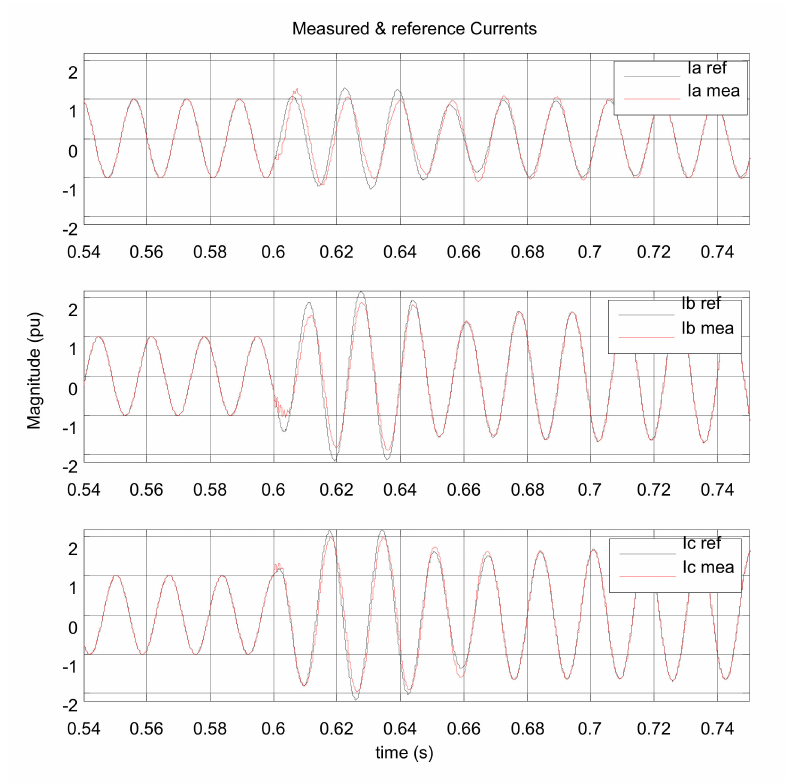
Figure 24. Current reference generated with the PNSC and grid current measured.